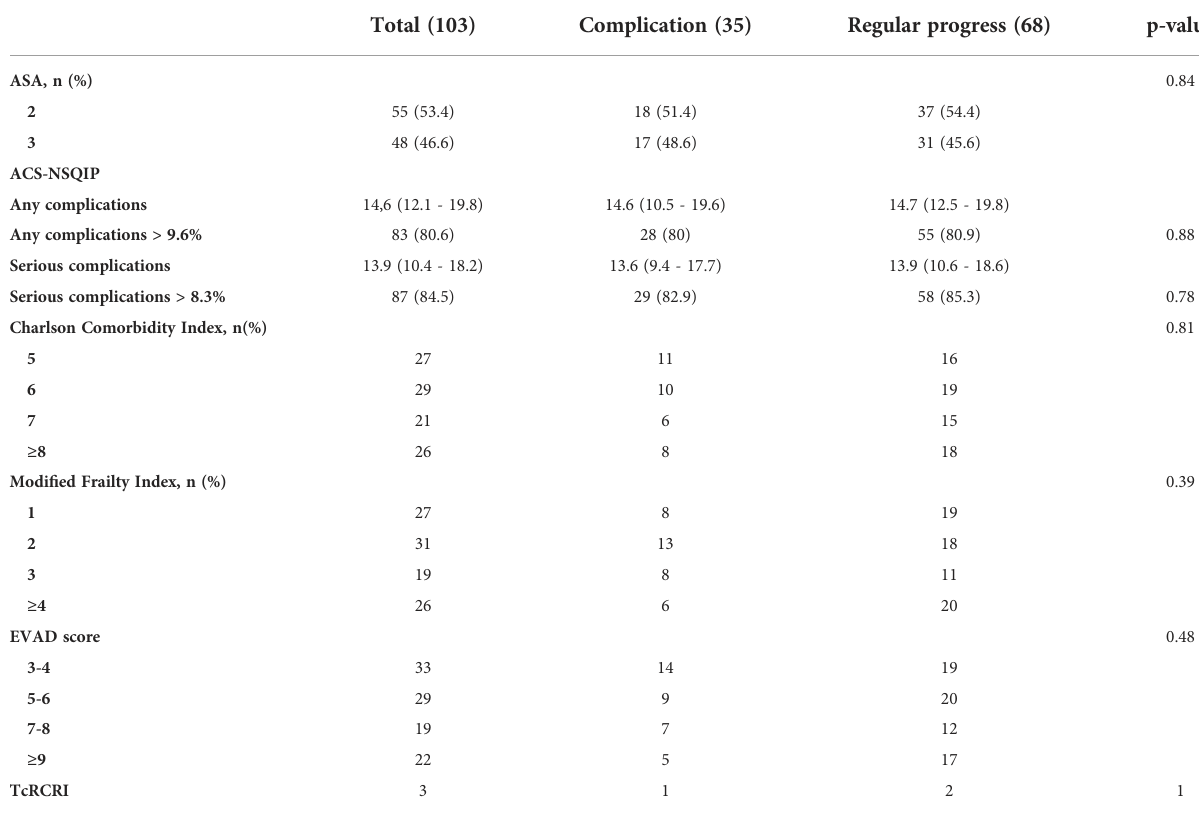
TABLE 2 Risk strati fi cation based on multiple